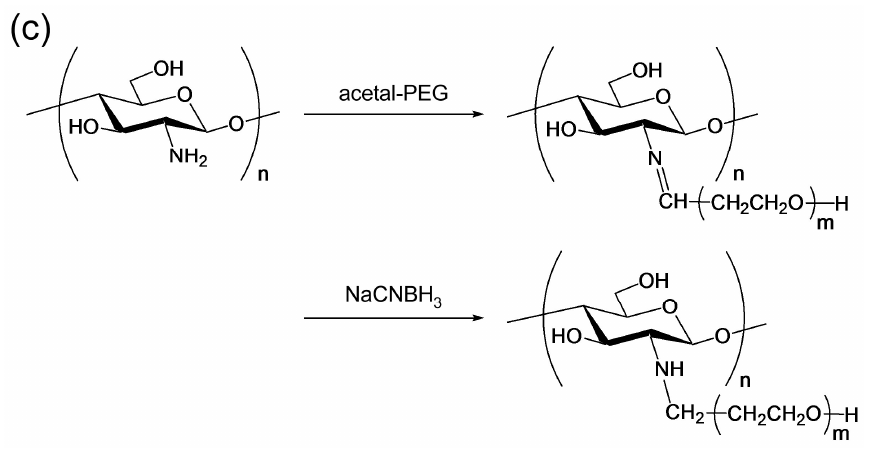
Figure 2. Scheme of the synthesis of ( a ) acetal-PEG; ( b ) acetal-PEG- b -PLA; and ( c ) PEG-grafted chitosan.